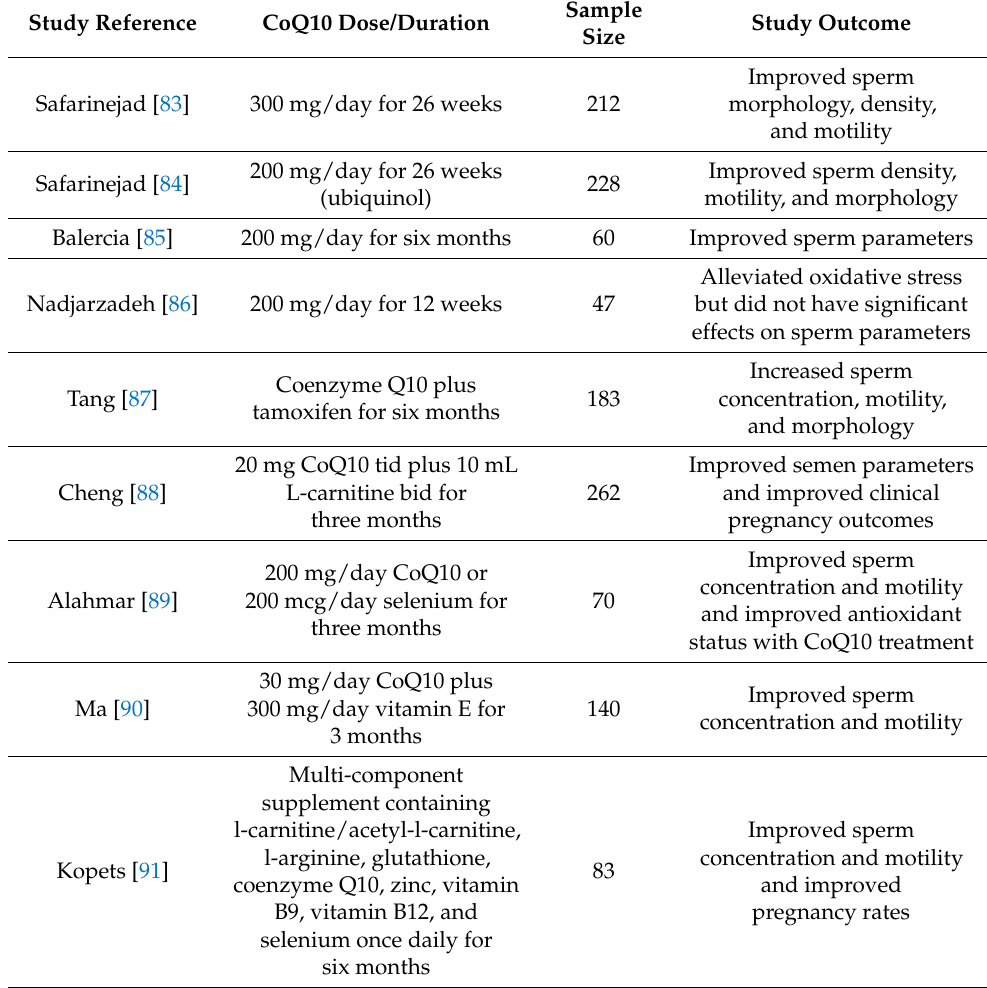
Table 1. Randomised controlled trials of CoQ10 Supplementation in male